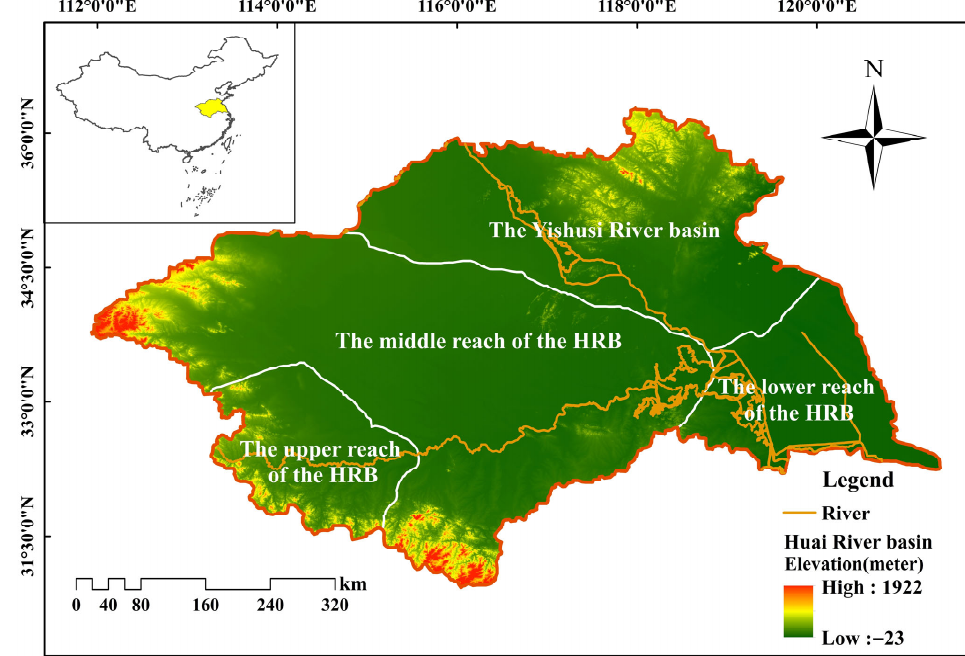
Figure 1. The location and elevation map of the Huai River basin.